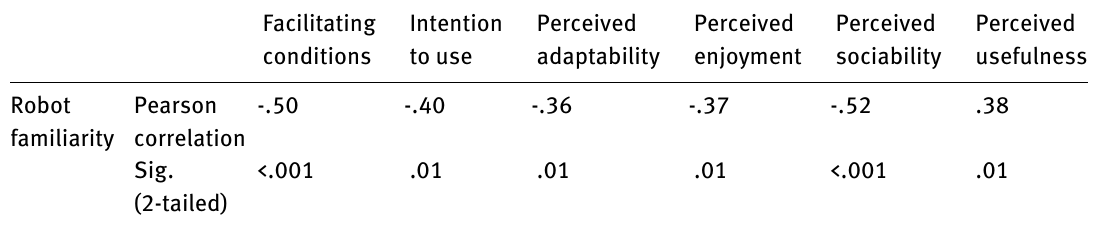
Table 2: Significant Correlations Between Robot Familiarity and Robot